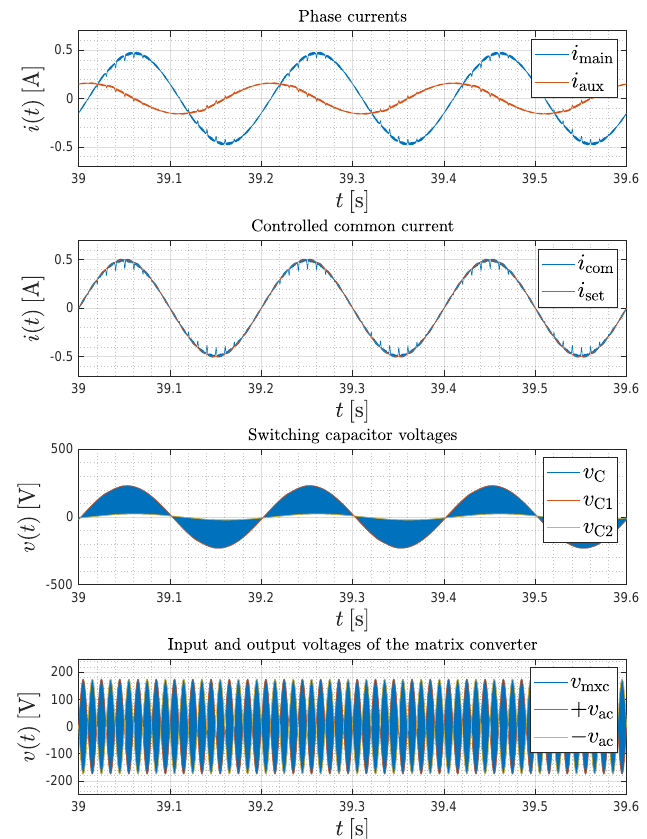
Figure 20. Simulated variables of phase shift feedback control at a frequency of 5